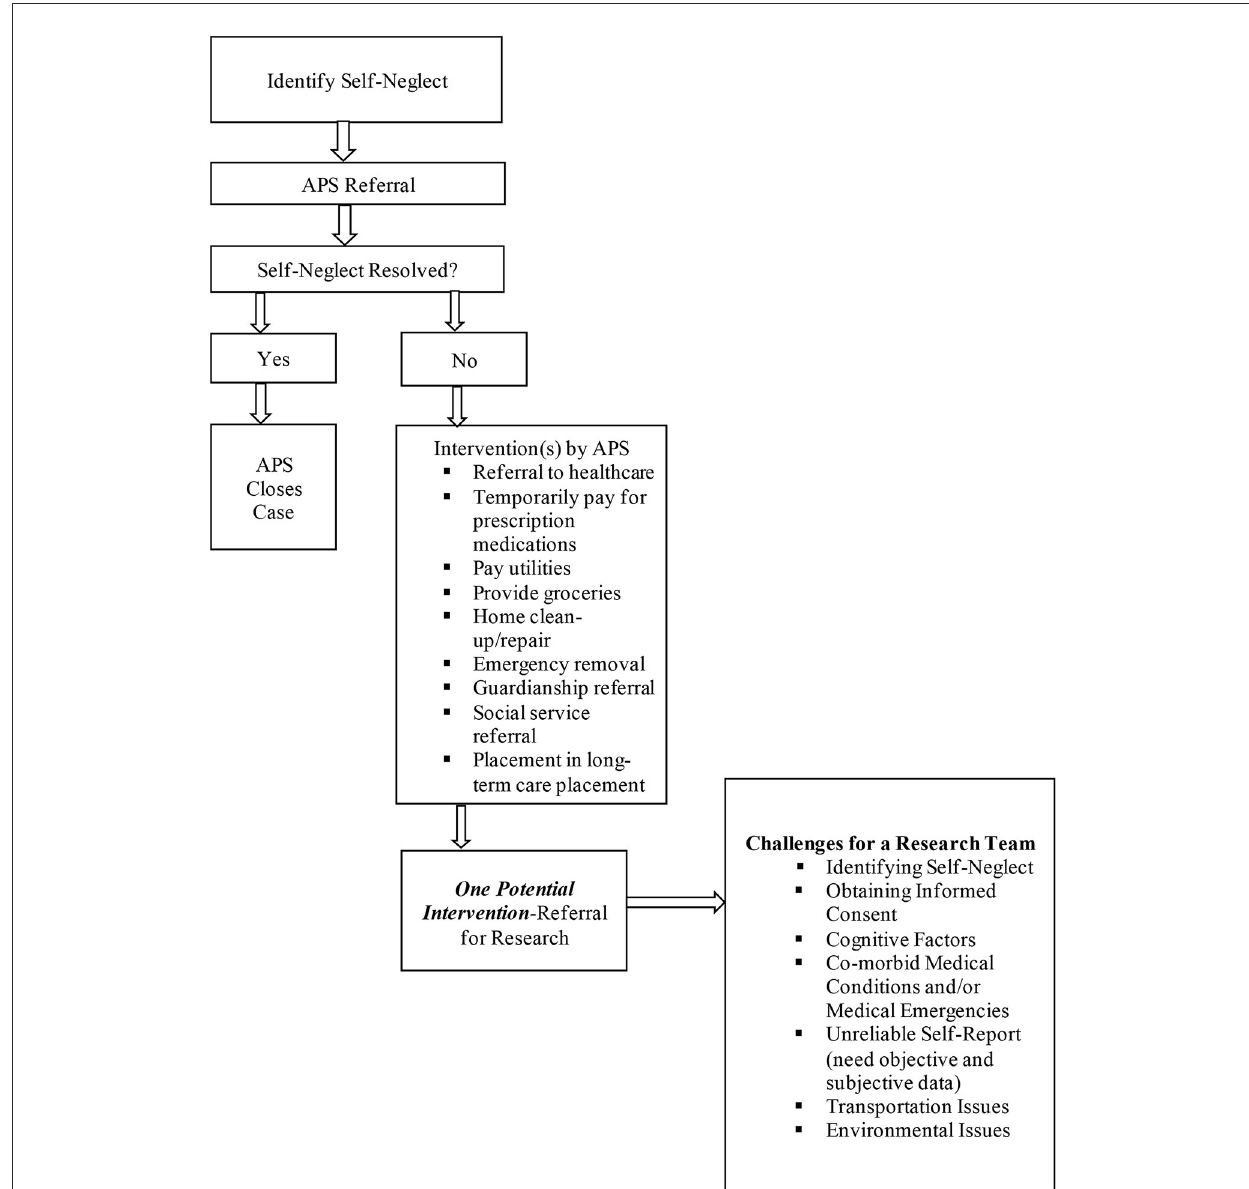
FIGURE1 Challenges of recruiting for self-neglect